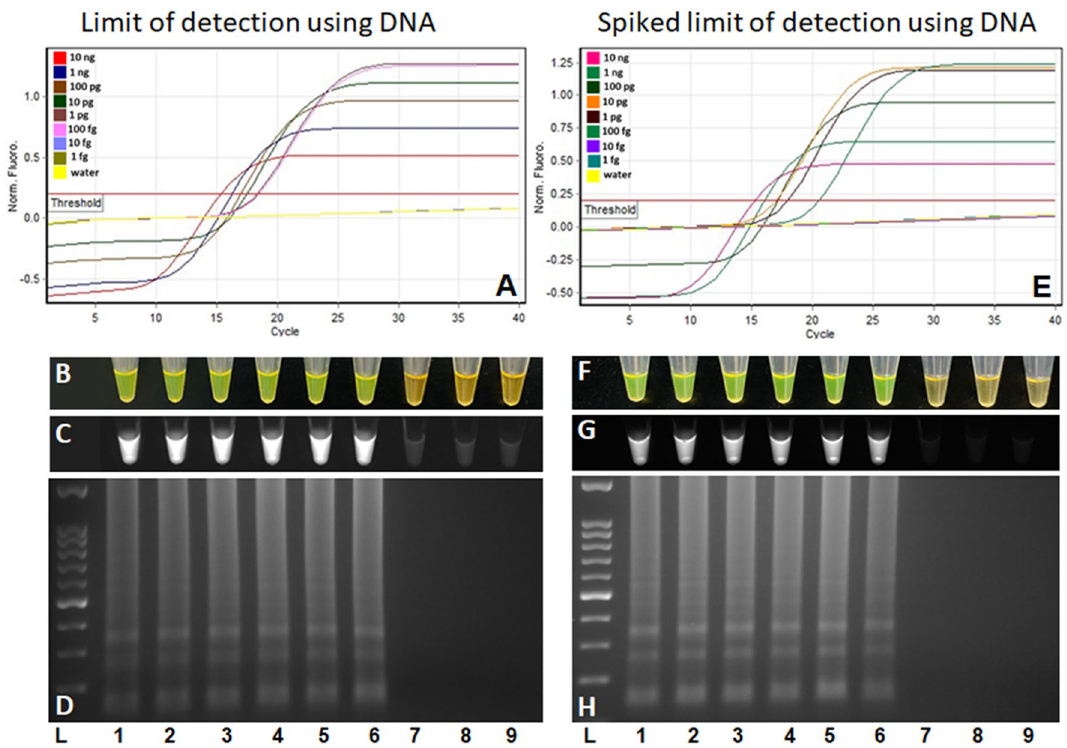
Figure 4. Detection limit of Pectobacterium parmentieri specific loop mediated isothermal amplification (LAMP) assay using pure genomic DNA. Ten-fold serially diluted genomic DNA (LMG29774) was used from 10 ng to 1 fg per reaction, indicated with lane 1 to 8. ( A , E ) Sigmoidal curves; ( B , F ) by adding SYBR Green I dye, color change from orange to bright green observed with naked eyes; ( C , G ) tubes observed under the UV light; ( D , H ) electrophoresis of amplified products on 2% agarose gel stained with ethidium bromide. Positive amplification was observed up to 100 fg (lane 6). Lane 9 is negative control (non-template control—water) and L is a 100 bp ladder. In the spiked assay, a 5 µl of crude host DNA was added to each reaction containing tenfold serially diluted genomic